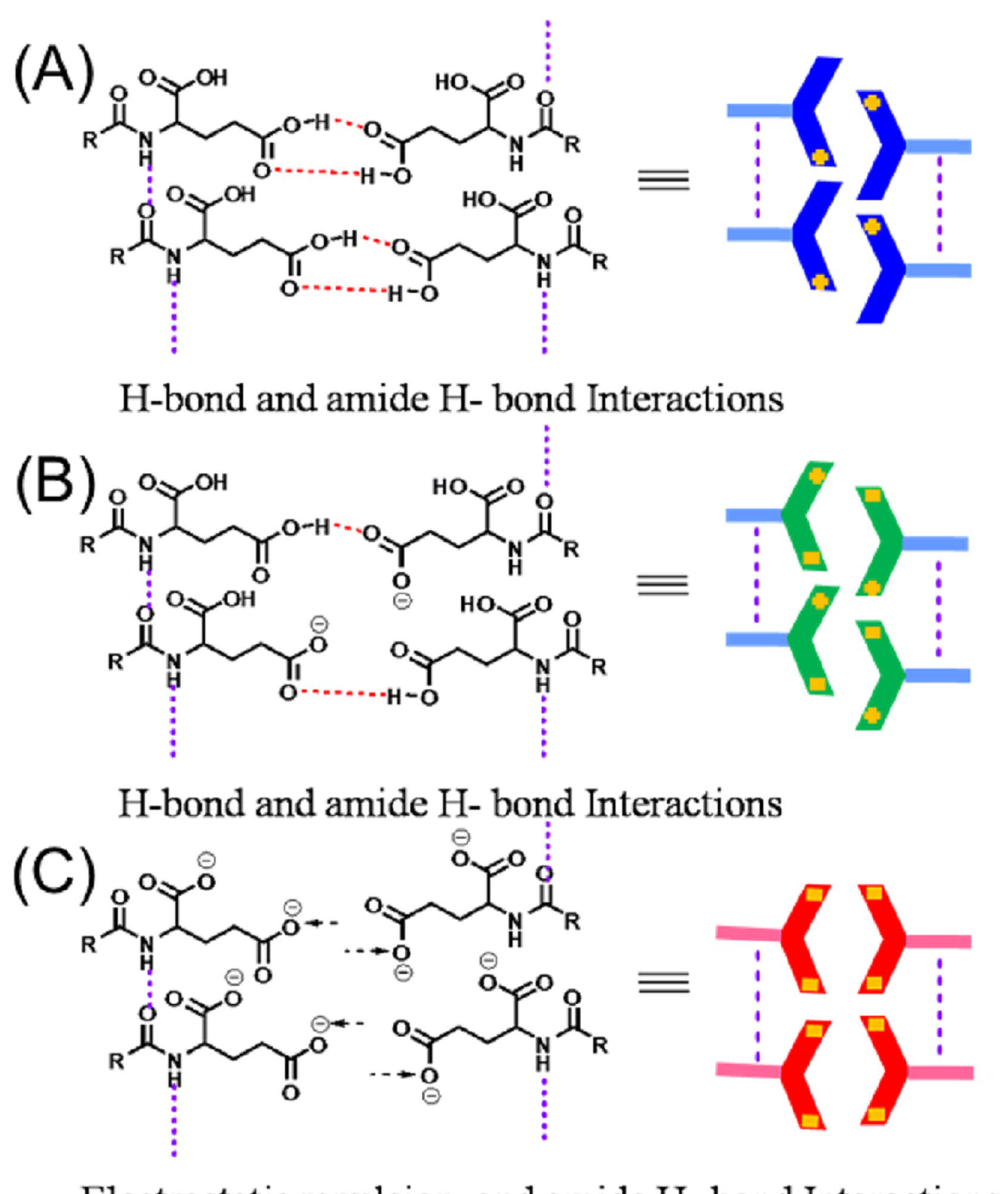
Figure 8. Schematic representation of the pH responsive supramolecular polymer formation of NDI-L-Glu ( 1 ); ( A ) at pH 3; amide H-bonding and expected π - π staking interactions; ( B ) at pH 7; H-bonding, amide H-bonding and expected π - π staking interactions; ( C ) at pH 9; electrostatic repulsion, amide H-bonding and expected π - π staking